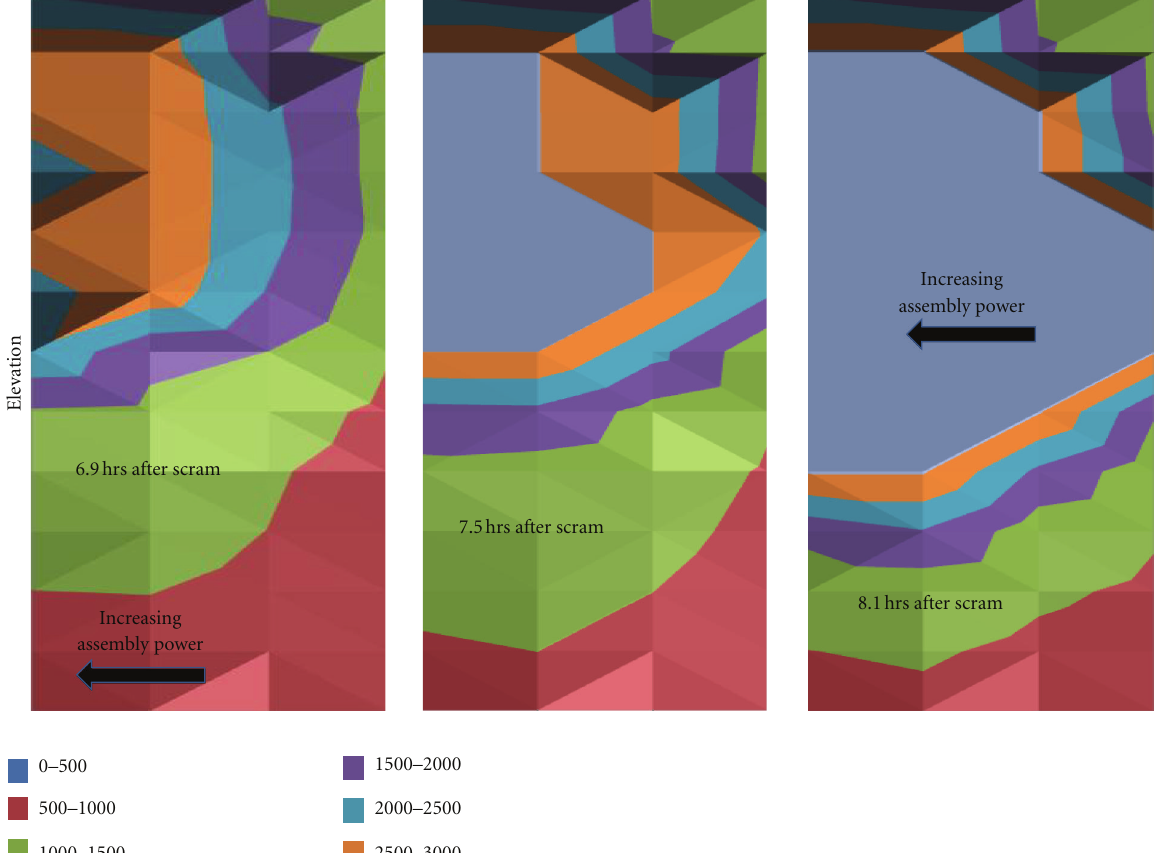
Figure 33: Core temperature distributions for a scenario without depressurization (all emergency water injection was terminated at 4.2 hours after reactor scram).